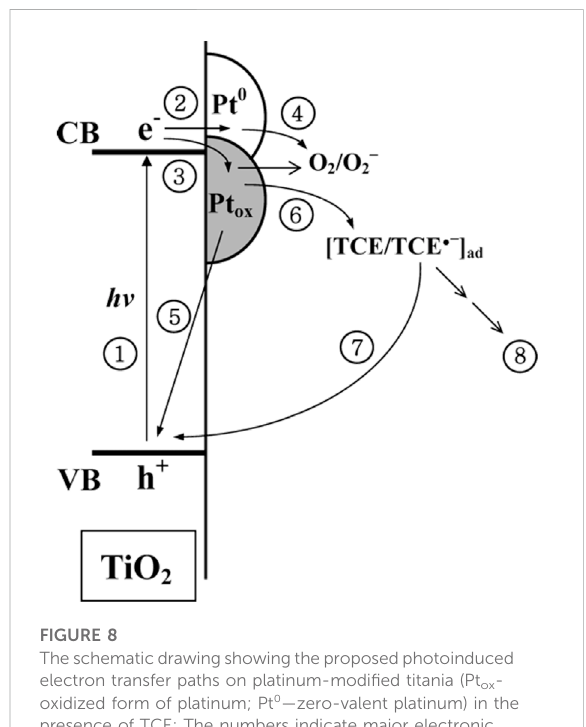
FIGURE 8 Theschematicdrawingshowingtheproposedphotoinduced electron transfer paths on platinum-modi fi ed titania (Pt ox - oxidized form of platinum; Pt 0 — zero-valent platinum) in the presence of TCE; The numbers indicate major electronic pathways: (1) band gap excitation; (2) electron trapping in the Pt 0 phase; (3) electron trapping in the Pt ox phase; (4) trapped electron transfer to O 2 ; (5) Pt ox -mediated recombination; (6) trapped electron transfer to TCE; (7) TCE-mediated recombination; (8) reductively initiated degradation of TCE. Adapted with permission from (Lee and Choi, 2005) with permission from